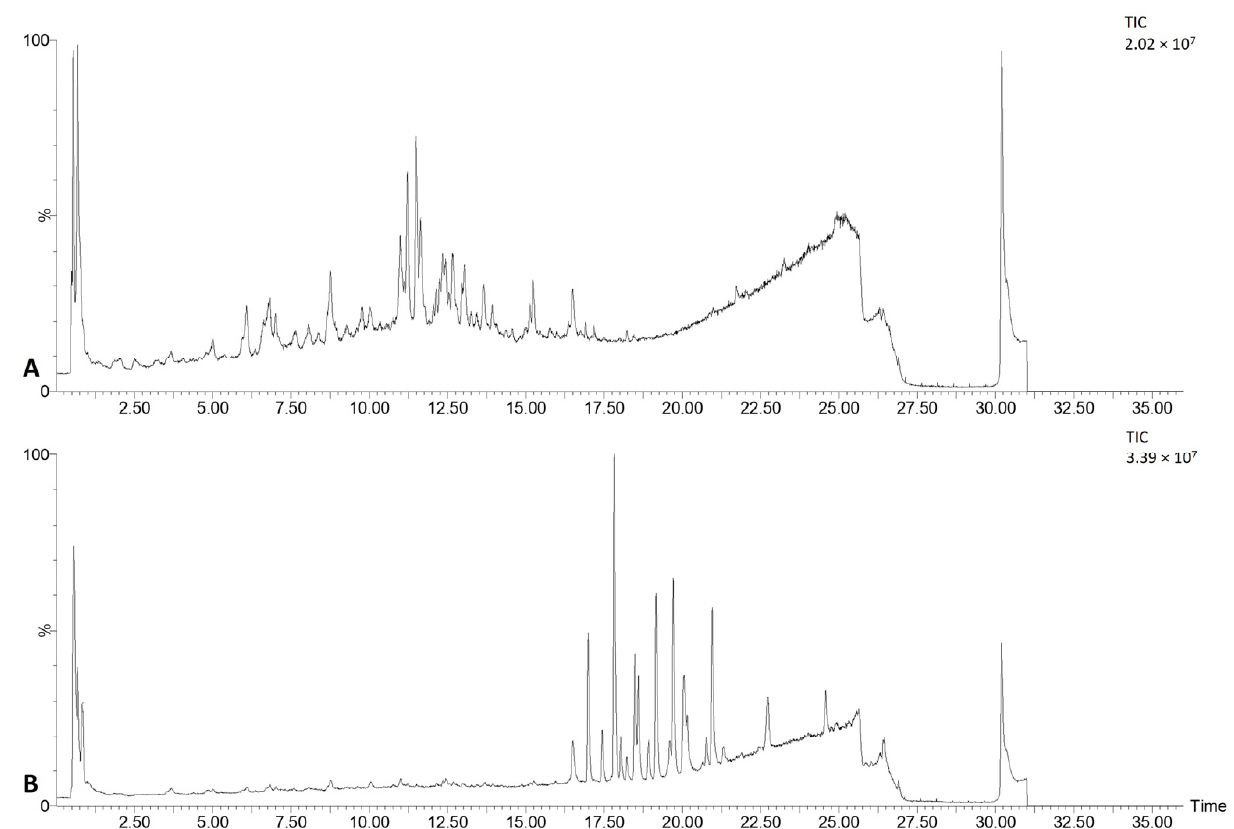
Figure 1. Total ion chromatogram of the F. ulmaria extract before ( A ) and after ( B ) in vitro gastroin- testinal biotransformation.